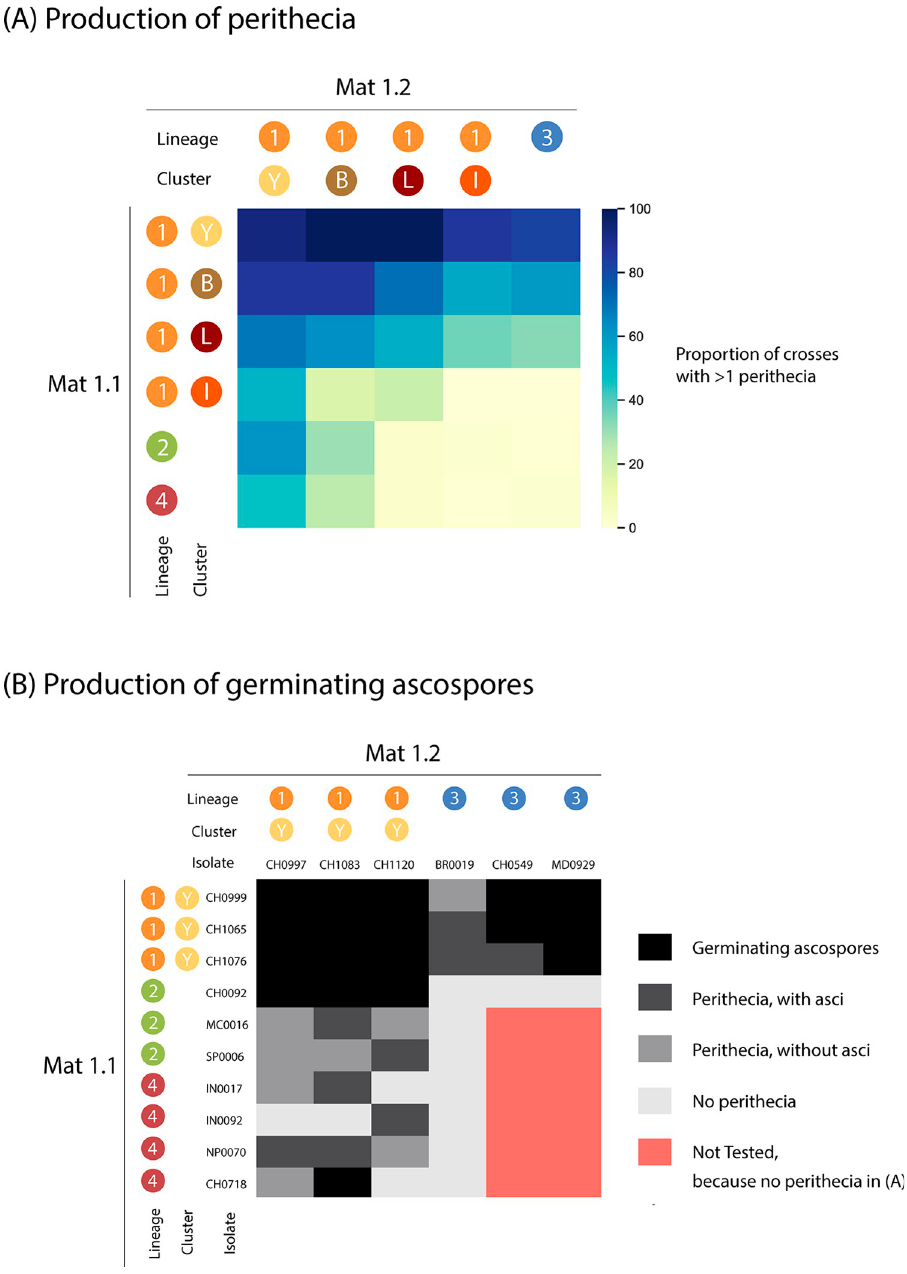
Fig 3. Success of crosses between lineages 2–4 and clusters within lineage 1 with (A) proportion of crosses producing at least one perithecium, (B) scoring of ascus formation and ascospore germination for a subset of crosses. rate of lineage 4 at 10˚C relative to other lineages and a significantly higher growth rate of line- age 1 at 15˚C, 20˚C, 25˚C and 30˚C relative to other lineages. Almost no sporulation was detected at 10˚C after 20 days of culture, with the few spores observed being not completely formed and divided by only one septum instead of two septa in mature conidia (sporulation curves and a full statistical treatment of the data are presented in S7 Text; data are reported in S12 Data). For all lineages, sporulation (weighted by mycelium colony size) increased with